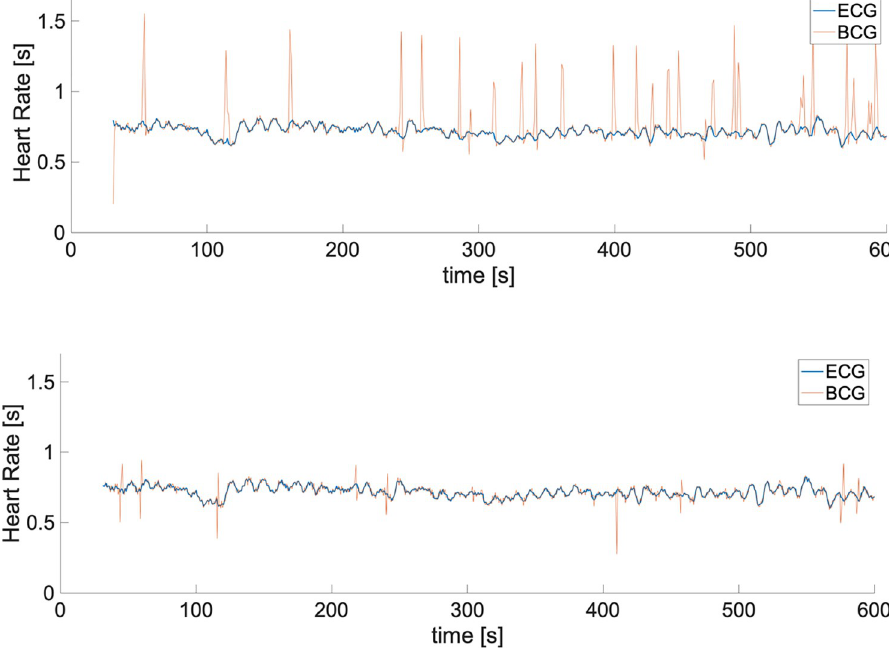
Fig 7. Comparison of HRV obtained from conventional algorithm and proposed method; (a) HRV obtained from conventional algorithm [21]; (b) HRV obtained from proposed